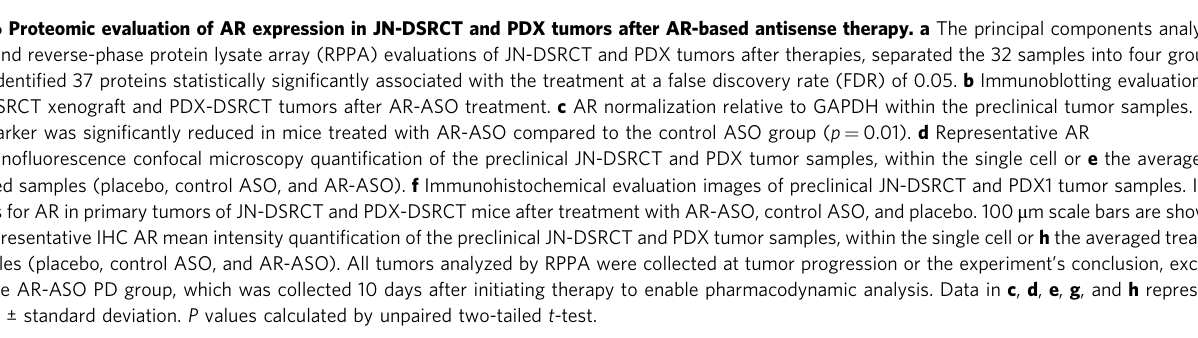
Fig. 6 Proteomic evaluation of AR expression in JN-DSRCT and PDX tumors after AR-based antisense therapy. a The principal components analysis plot and reverse-phase protein lysate array (RPPA) evaluations of JN-DSRCT and PDX tumors after therapies, separated the 32 samples into four groups and identi fi ed 37 proteins statistically signi fi cantly associated with the treatment at a false discovery rate (FDR) of 0.05. b Immunoblotting evaluation of JN-DSRCT xenograft and PDX-DSRCT tumors after AR-ASO treatment. c AR normalization relative to GAPDH within the preclinical tumor samples. AR biomarker was signi fi cantly reduced in mice treated with AR-ASO compared to the control ASO group ( p = 0.01). d Representative AR immuno fl uorescence confocal microscopy quanti fi cation of the preclinical JN-DSRCT and PDX tumor samples, within the single cell or e the averaged treated samples (placebo, control ASO, and AR-ASO). f Immunohistochemical evaluation images of preclinical JN-DSRCT and PDX1 tumor samples. IHC stains for AR in primary tumors of JN-DSRCT and PDX-DSRCT mice after treatment with AR-ASO, control ASO, and placebo. 100 μ m scale bars are shown. g Representative IHC AR mean intensity quanti fi cation of the preclinical JN-DSRCT and PDX tumor samples, within the single cell or h the averaged treated samples (placebo, control ASO, and AR-ASO). All tumors analyzed by RPPA were collected at tumor progression or the experiment ’ s conclusion, except mean ± standard deviation. P values calculated by unpaired two-tailed